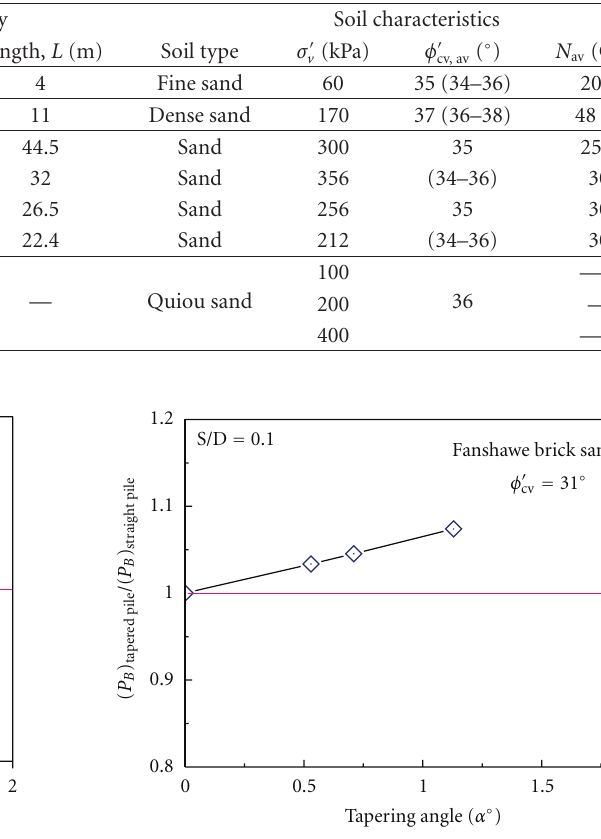
Figure 9: Normalized end-bearing capacity of Fanshawe brick sand and di ff erent pile tapering angles.